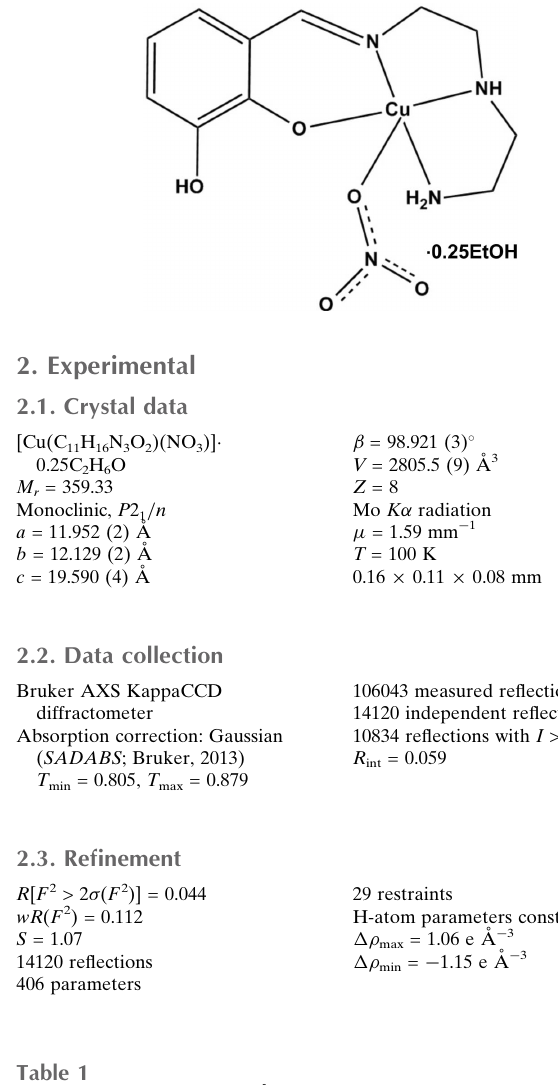
Hydrogen-bond geometry (A˚ , (cid:4)